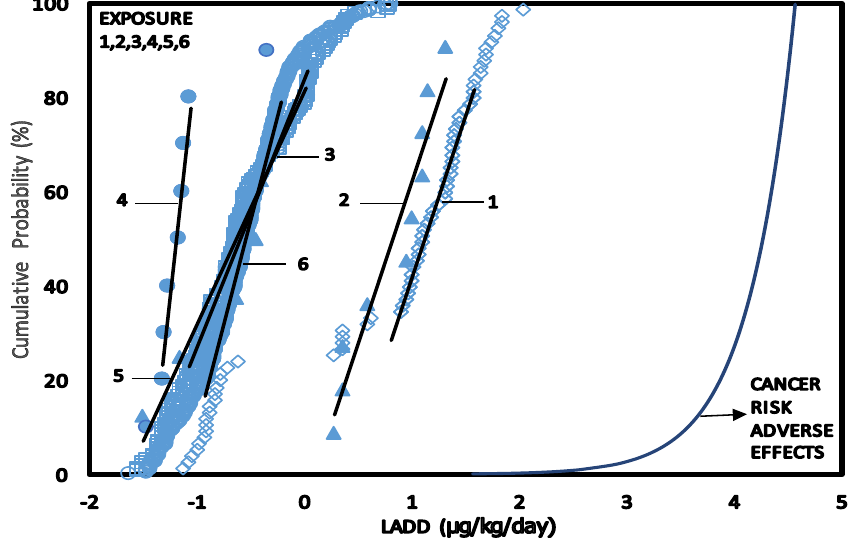
Figure 7. CPD plots lifetime exposure to benzene concentrations in air of service station (LADD) for scenarios 1–6 and Adverse Effects.